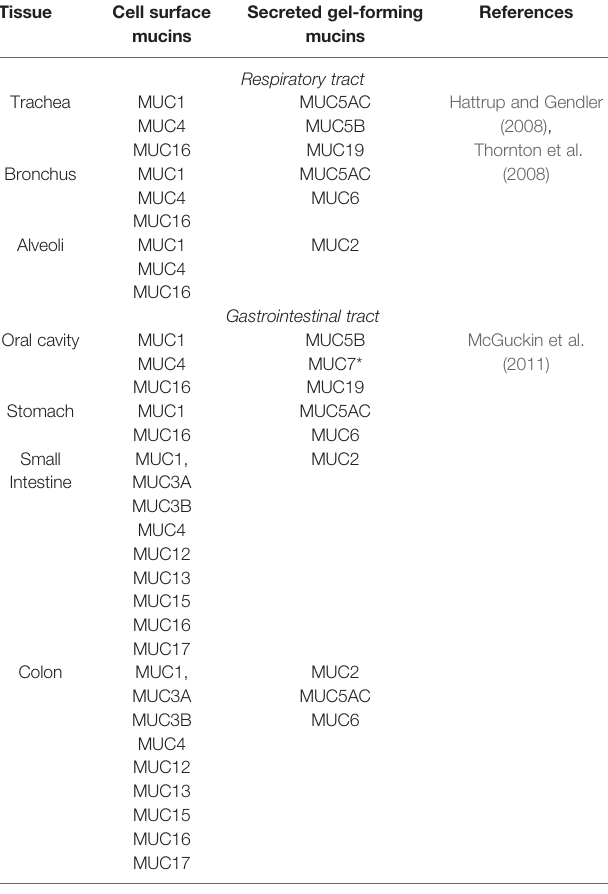
TABLE 1 | Expression of mucins throughout the